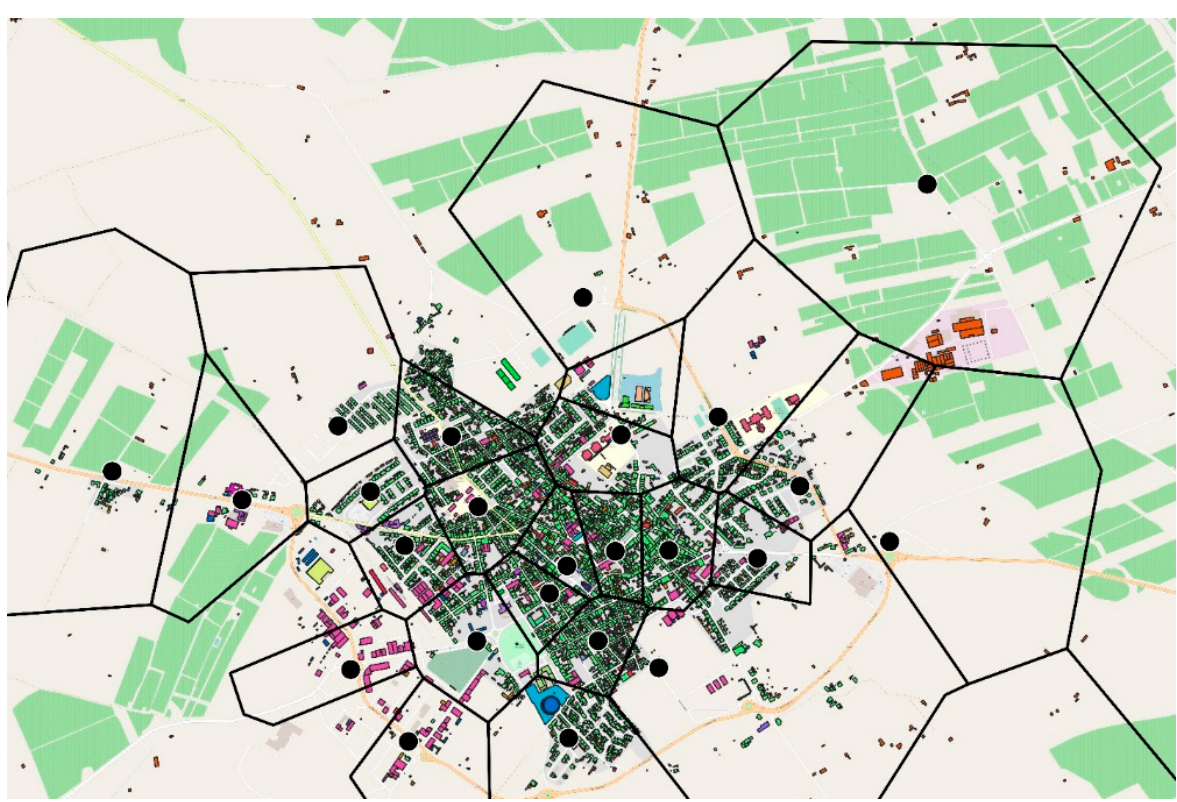
Figure 6. GIS representation of part of the map of Reguengos de Monsaraz, showing the power transformers (dark full circles), the rooftop cadaster and the determined Voronoi polygons with power transformers as generating points.